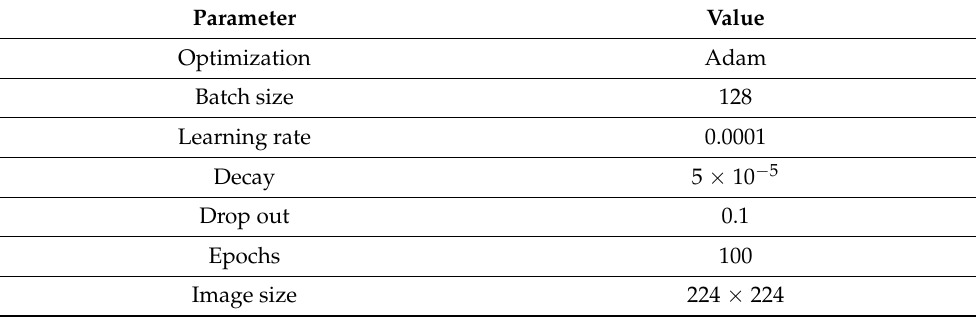
Table 4. Training parameter settings.